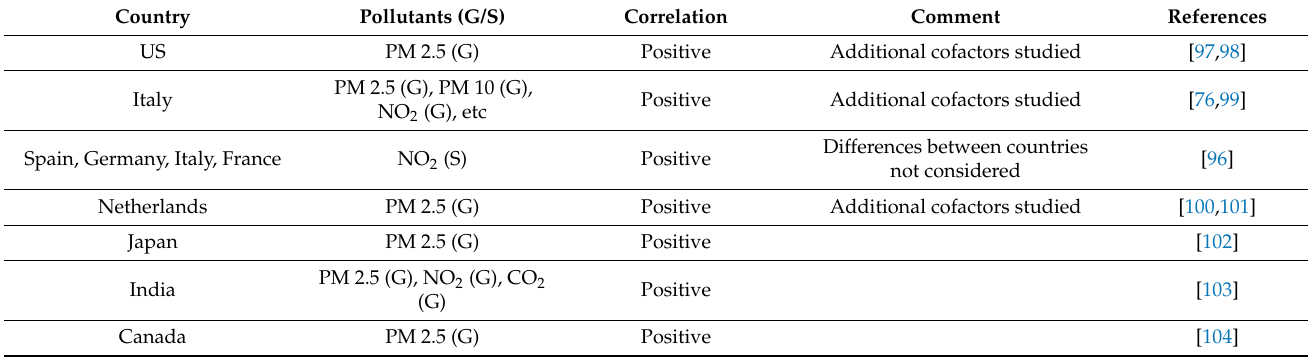
Table 5. A list of correlational studies between long-term exposure to air pollution and incidence of COVID-19 at a country-wide or cluster of countries level. Studies including smaller geographical areas have not been listed as well as those considering the short-term hypothesis (pollution particles acting as virus carriers). The pollutants are specified whether to having been collected from ground (G) or satellite (S)